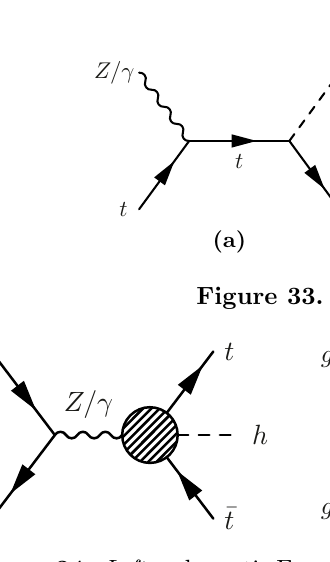
Figure 34. Left : schematic Feynman diagram for the EW-induced t (cid:22) th process and its embedding of the t Z t h and t (cid:13) t h subamplitudes. Middle : sample Feynman diagram for QCD-induced t (cid:22) th ! !